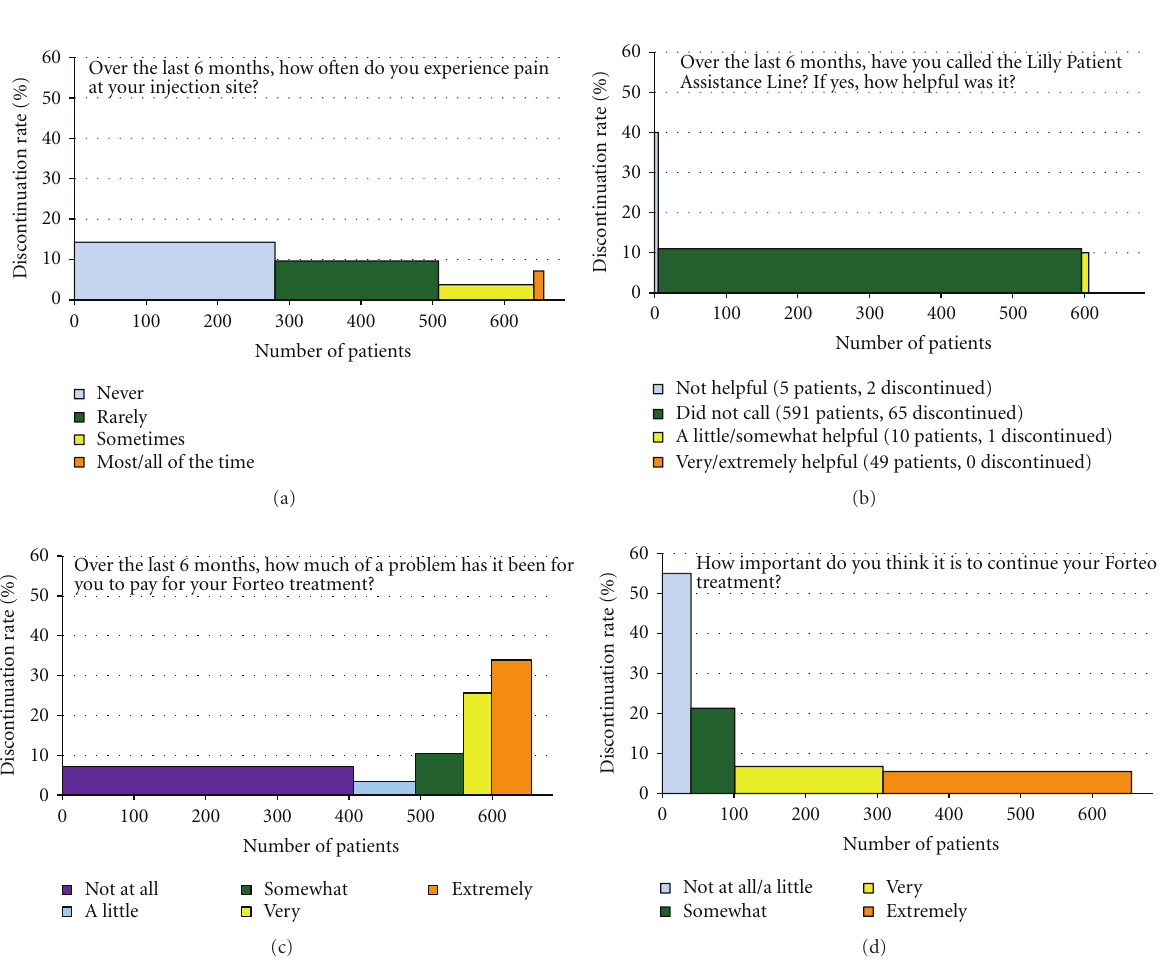
Figure 3: Responses to QF2 significantly associated with late discontinuation (Cochran-Armitage trend test). Additional significant associations had trends similar to the questions shown and included: Over the last 6 months, have you experienced any side e ff ects with the drug, Forteo? If yes, were they mild, moderate, or severe? Please think about the physician who is treating you with Forteo: How knowledgeable is the physician about treatment with